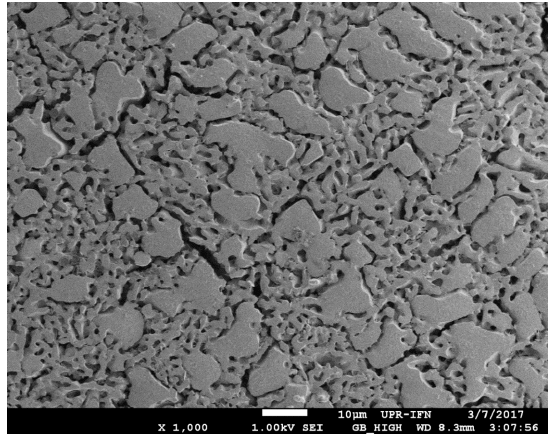
Figure 2. SEM images of: ( a ) EC and; ( b ) HC-1 samples solidified in a copper mold and corroded for 24 h in 10 vol. % NaOH aqueous solution.